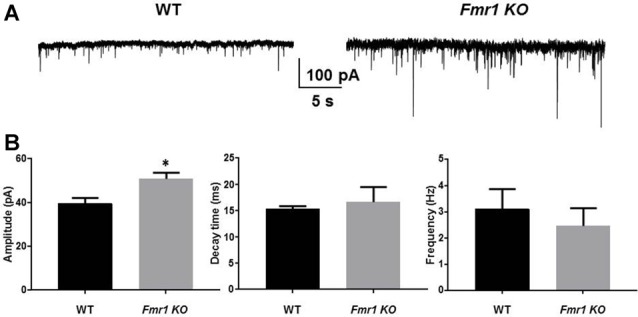
Fmr1 KO mice display alterations in phasic current. Recordings were made from DGGCs in hippocampal slices from p21-35 WT, or Fmr1 KO mice (A). Fmr1 KO mice displayed larger spontaneous inhibitory post synaptic currents (sIPSC) amplitudes compared to age-matched controls as seen in (B) mean sIPSC amplitude, decay, and frequency from WT and Fmr1 KO mice (*significantly different to WT controls, see text for p value; t-test, from seven slices).